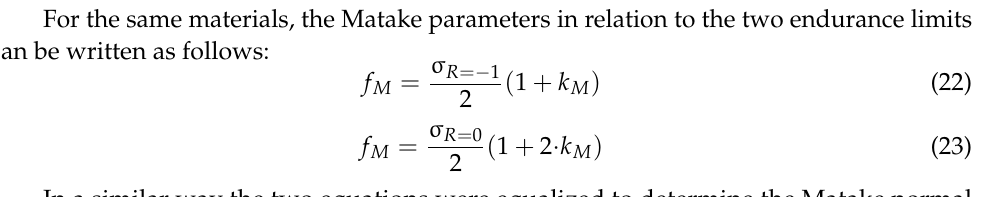
Figure 18. The Findley fatigue usage factor determined by